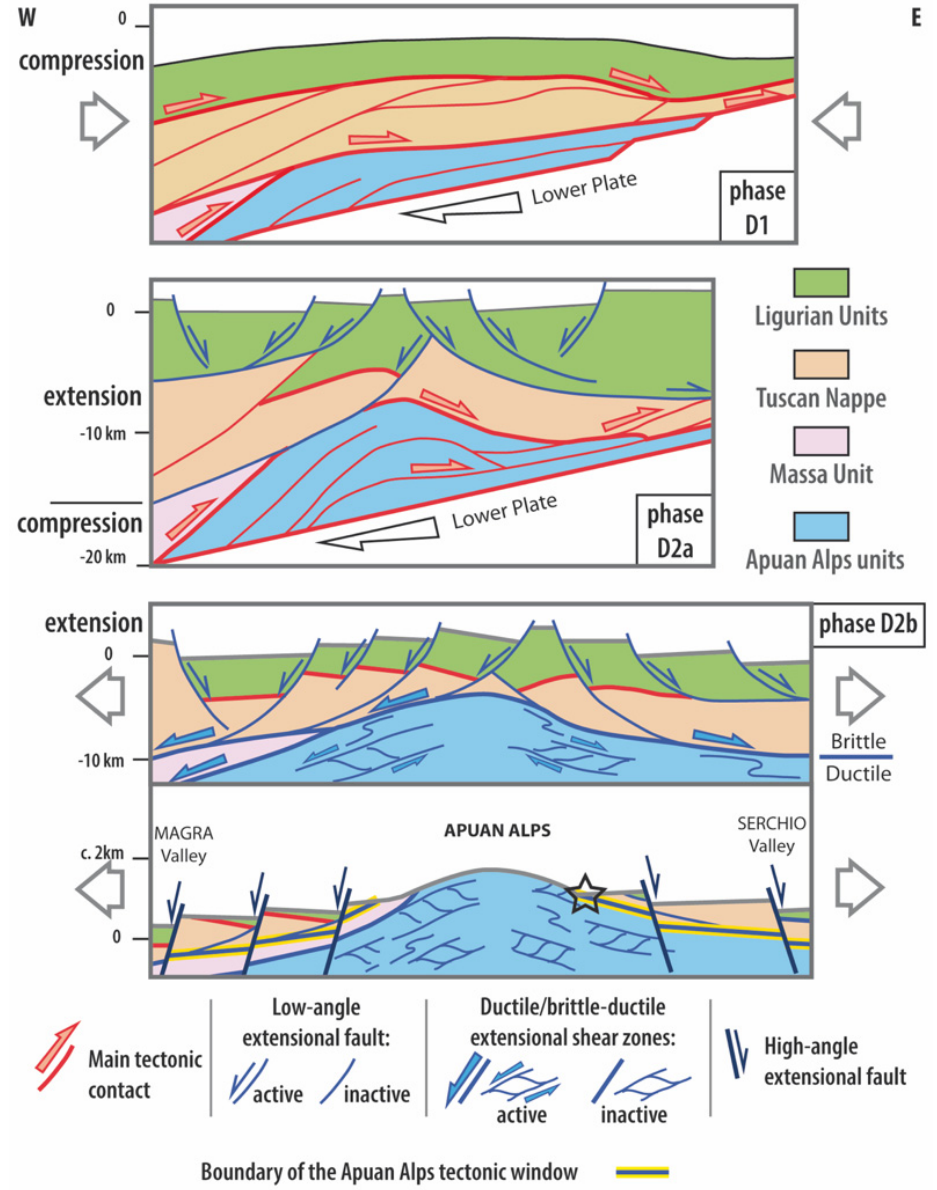
Figure 2. Commonly accepted evolutionary model of the Apuan Alps (modified after Carmignani and Kligfield, [30]). The star shows the location of the boundary of the Apuan Alps tectonic window geosite described in Section 5.1.